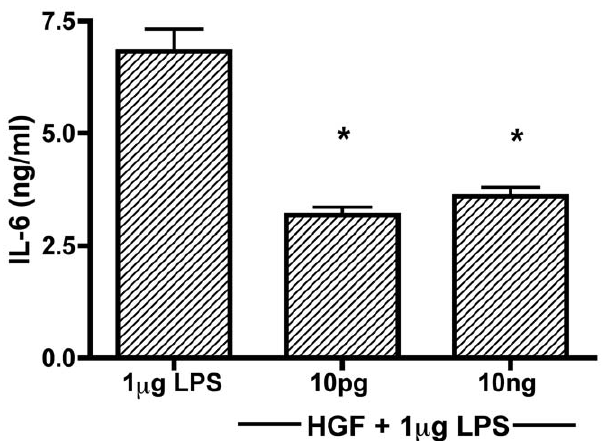
Figure 3. Deletion of the HGF receptor MET demonstrates a reversal in the effects of HGF on LPS stimulated BMM. BMM derived from either macrophage specific MET conditional knockout mice (MET fl/fl :cre lysZ + / 2 ) or their wild type littermate controls (MET fl/fl : cre lysZ 2 / 2 ) were pretreated with or without 1, 10 and 100 pg HGF for 24 hours and stimulated with 1 m g/ml LPS. Cell culture media was collected (24 h) and IL-6 levels were measured by ELISA. Results are representative of two independent experiments done in triplicate.